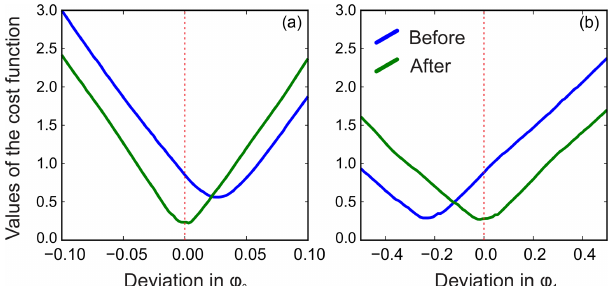
Figure 6. Phase adjustment of the experimental spectrum of thi- amine. The norm of the residual baseline (cid:107) r b (cid:107) as a function of de- viation in the parameters of the linear phasing model from their current values (0.0 on the horizontal axes), ϕ 0 (a) and ϕ 1 (b) be- fore and after their adjustment. The optimal phasing parameters es- timated with the initial least-squares fit using Eq. (3) (blue lines) are suboptimal in the sense of the adjustment criterion of Eq. (8). A median filter of size w m ≈ 100 · FWHM is used in this example.